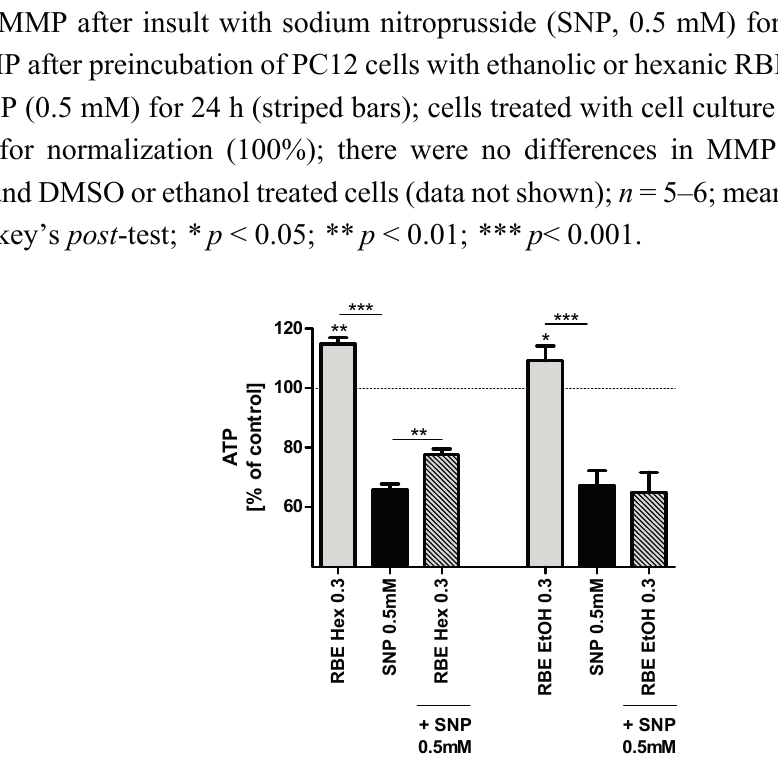
Figure 2. ATP concentrations of PC12 cells after 24-h incubation with 0.3 mg/mL hexanic (RBE Hex) or ethanolic (RBE EtOH) rice bran extract (RBE, grey bars); ATP concentrations after insult with sodium nitroprusside (SNP, 0.5 mM) for 6 h (black bars) and ATP concentrations after preincubation of PC12 cells with ethanolic or hexanic RBE for 1 h and insult with SNP (0.5 mM) for 6 h (striped bars); cells treated with cell culture medium served as control for normalization (100%); there were no differences in ATP between medium treated and DMSO or ethanol treated cells (data not shown); n = 6–7; mean ± SEM; ANOVA with Tukey’s post- test; * p < 0.05; ** p < 0.01; *** p <